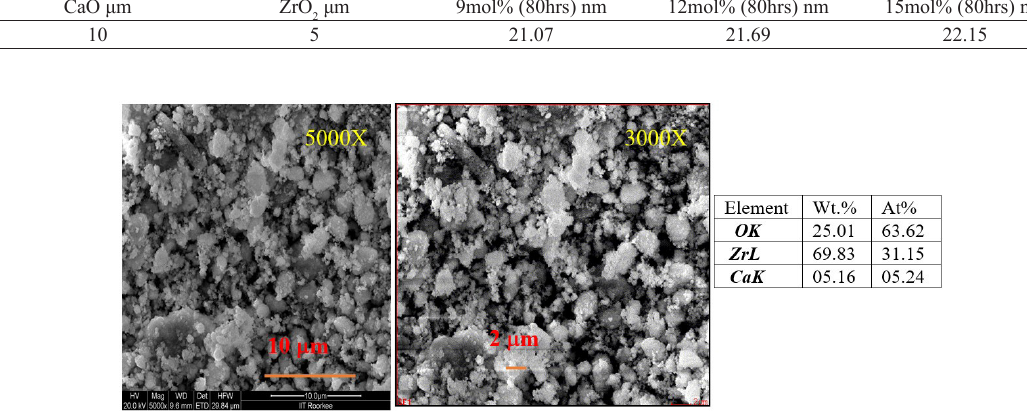
Figure 2. SEM and EDS analysis for 12 mol % CaO powder sample.